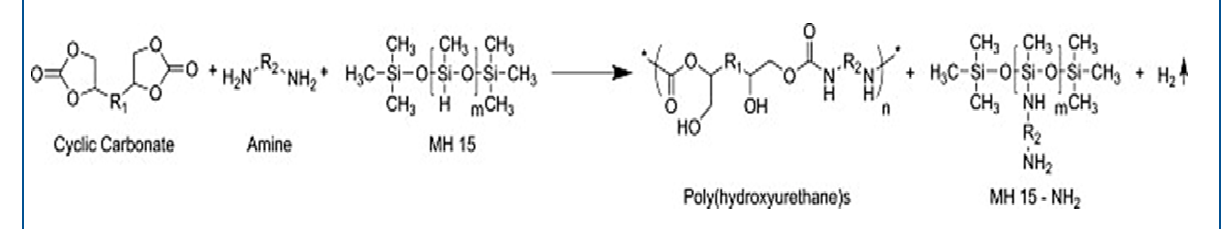
Figure 4. Reaction to obtain NIPUF by using MH15. Reprinted from ref [33] with permission from the publisher.